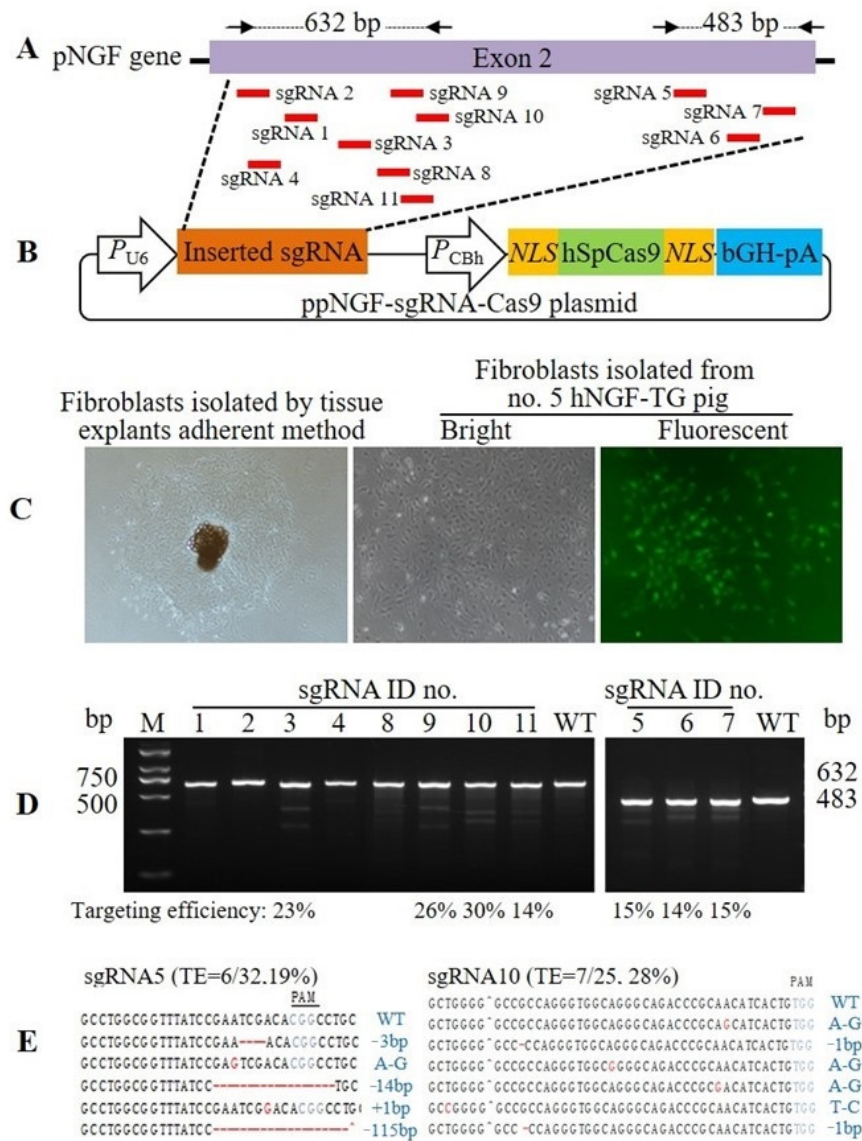
Figure 6. Design and selection of sgRNAs for efficient targeting of the pNGF gene via the CRISPR/Cas9 system. ( A ) Location of the recognition sites of 11 designed sgRNAs that target the pNGF gene. ( B ) The map of the CRISPR/Cas9 system expression plasmid (ppNGF ‐ sgRNA ‐ Cas9) that targets the pNGF gene. ( C ) Ear fibroblasts isolated from no. 5 F 0 hNGF ‐ TG pig for the second round of genetic modification. ( D ) T7E1 assay of the targeting efficiency of 11 designed sgRNAs. 1–11: the ID no. of 11 designed pNGF ‐ targeting sgRNAs. ( E ) Analysis of the targeting efficiency of sgRNA5 and sgRNA10 by sequencing the PCR amplification products of their targeting sites following transfection of the ppNGF ‐ sgRNA5 ‐ Cas9 and ppNGF ‐ sgRNA10 ‐ Cas9 plasmids into pig fibroblasts. TE, targeting efficiency.